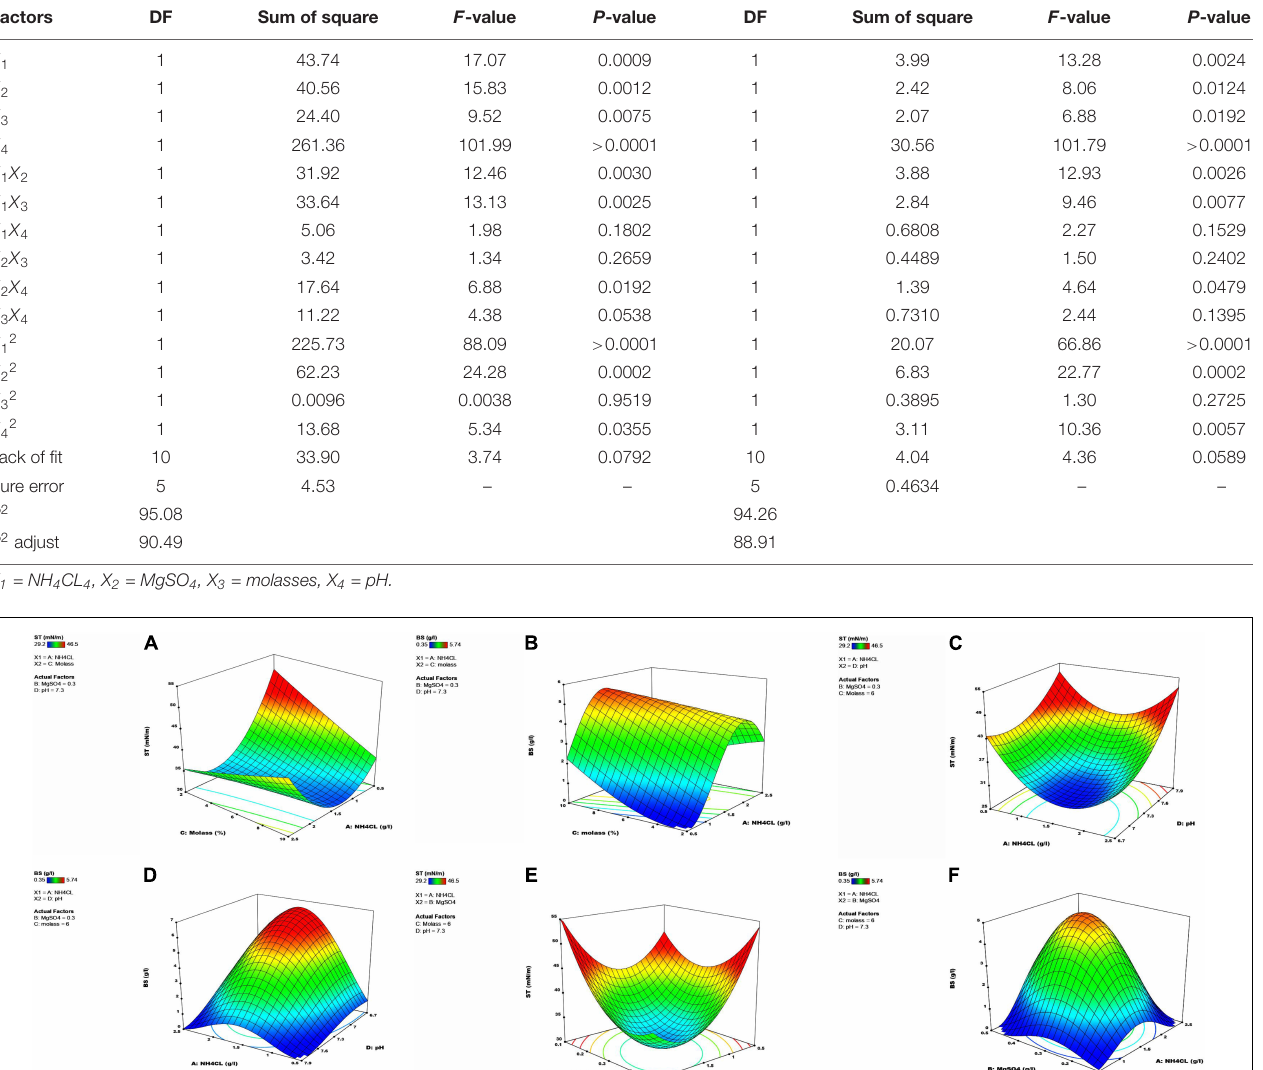
TABLE 4 | Analysis of variance (ANOVA) for the two response variables of surface tension (ST) and produced biosurfactant (BS) based on the central composite design. ST (mN/m) BS (g/l)